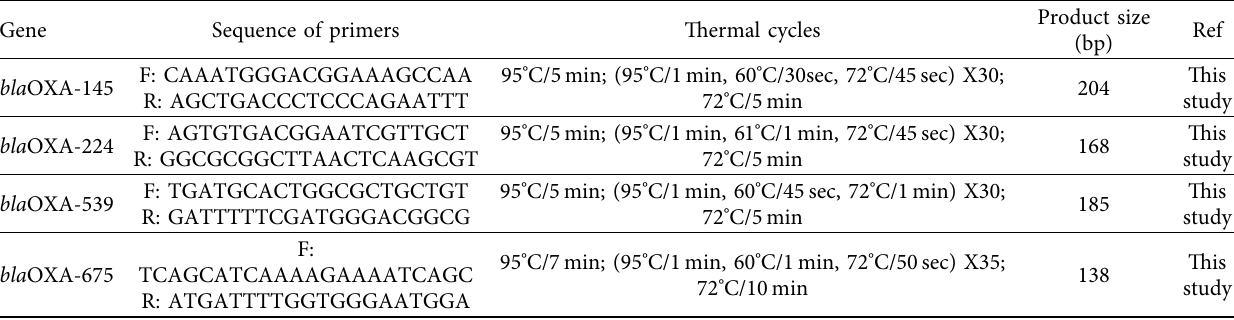
Table 1: Oligonucleotide sequences used in this study and thermal cycling conditions. Gene Sequence of primers Thermal